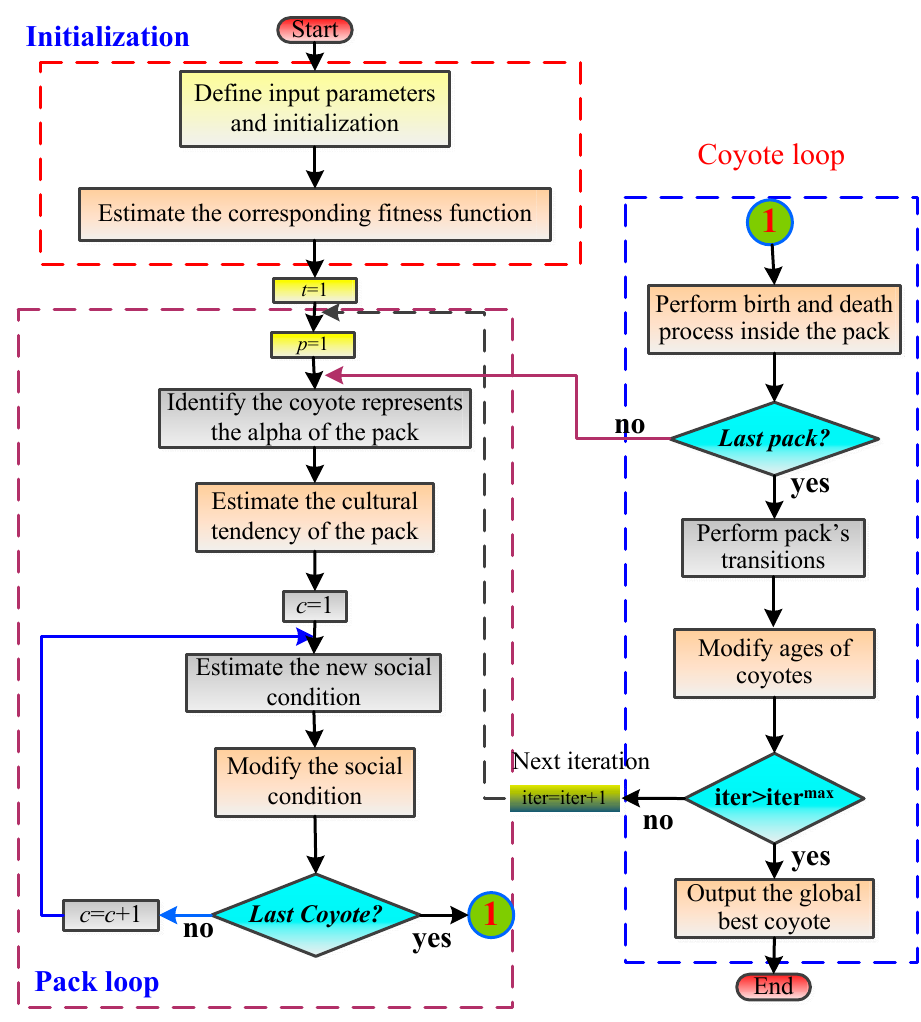
Figure 5. Optimization process of coyote optimization algorithm (COA).